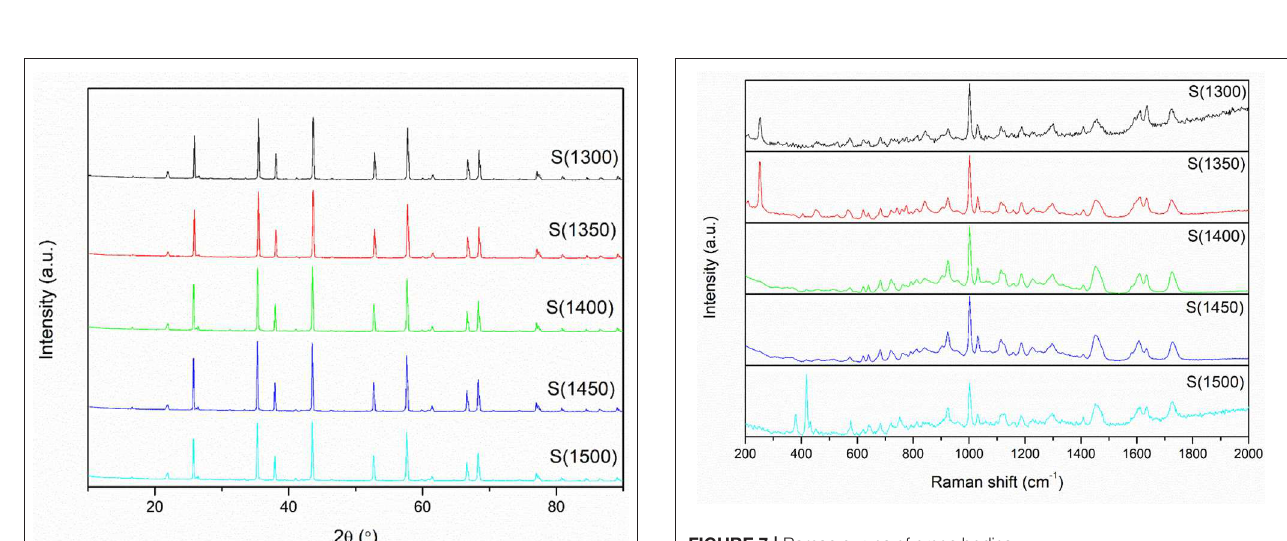
FIGURE 7 | Raman curves of green